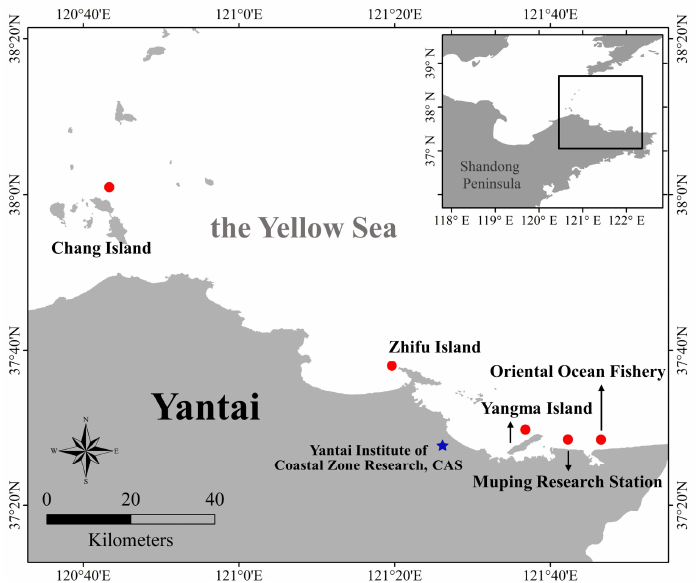
Figure 5. Satellite map of the five sampling locations. Seafood samples were from Zhifu Island, and water samples were from four other sampling locations, including near Chang Island, near Yangma Island, Muping Coastal Environment Research Station and Oriental Ocean Fishery.